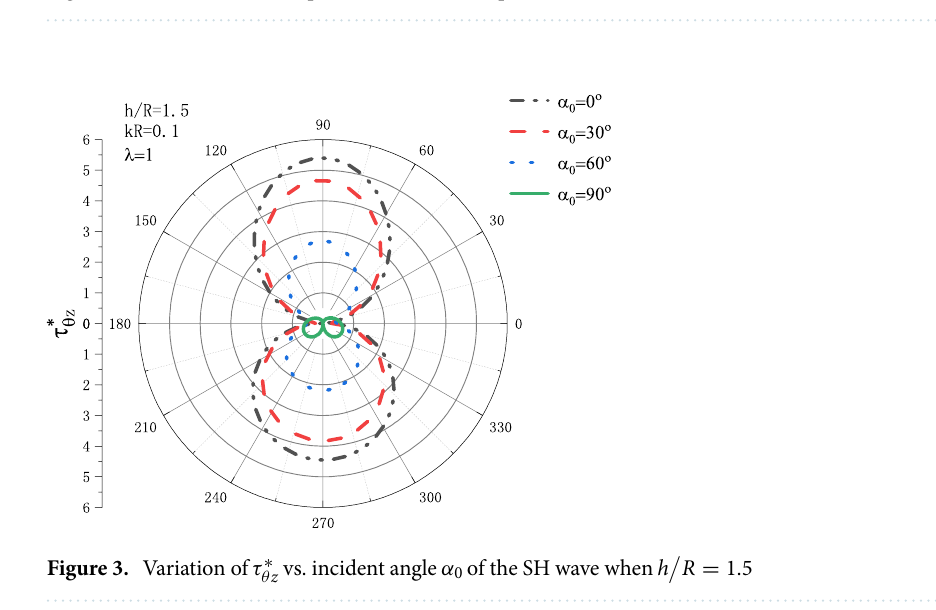
Figure 2. Verification of the present method (compared with reference 22 ).